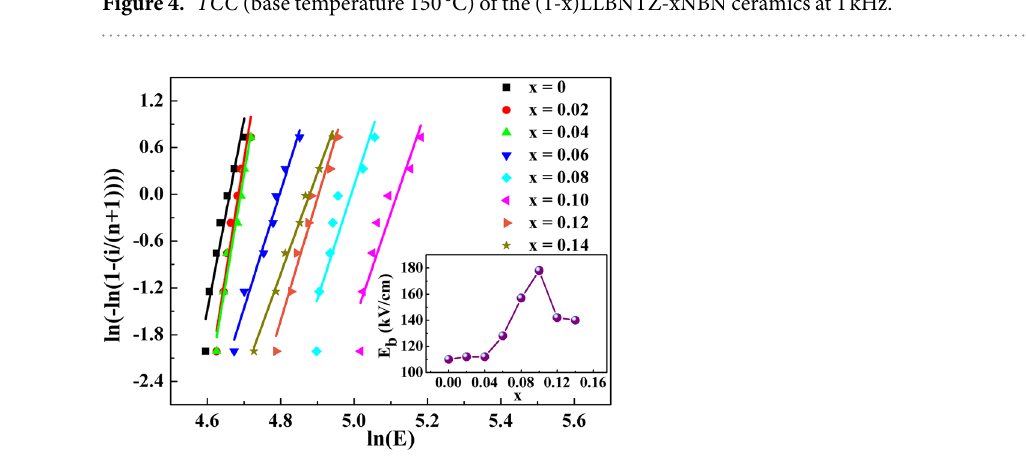
Figure 4. TCC (base temperature 150 °C) of the (1-x)LLBNTZ-xNBN ceramics at 1 kHz.